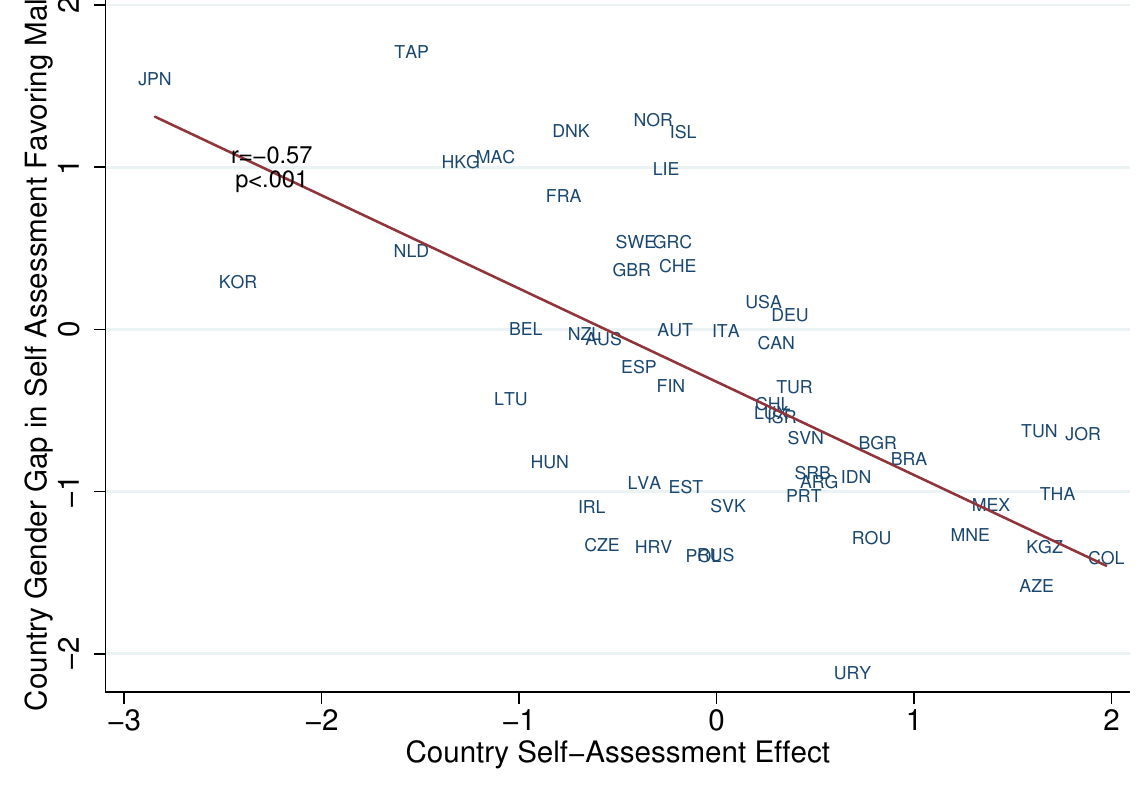
Figure 2: Gender gap in self-assessment versus country self-assessment